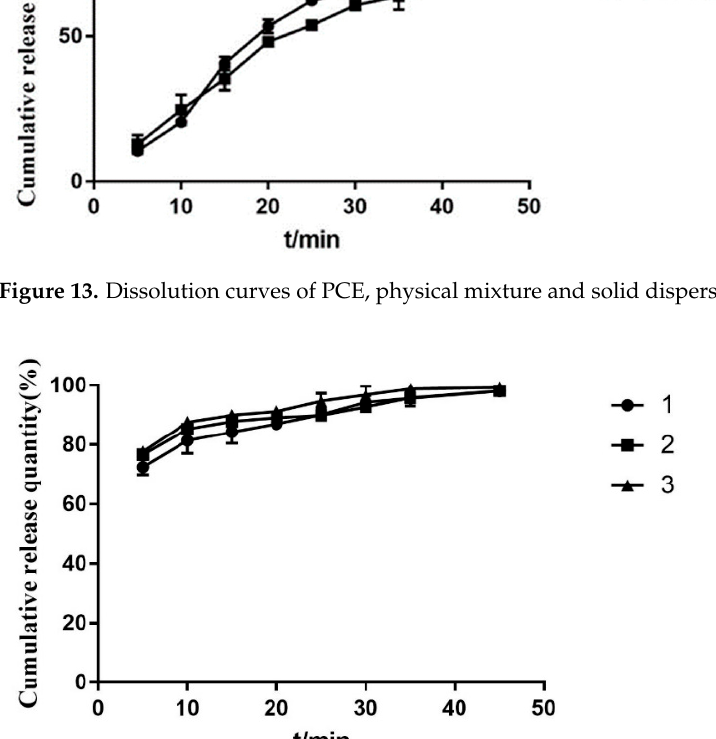
Figure 15. IR spectrum of PCE, carriers, PCE − PM and PCE − SD. 2.6.2. SEM It can be seen from Figures 3–16 that resveratrol in Polygonum cuspidatum extract ex- ists in the form of block crystal, the micro morphology of carrier hpmcas is irregular loose porous block, P188 is smooth ball, and there are round holes in the section. The physical mixture includes resveratrol in the form of massive crystals, and carriers hpmcas and P188 are in an irregular form. No massive crystals are found in the solid dispersion, which is dense and irregularly arranged. It is speculated that resveratrol exists in the carrier in amorphous or molecular state.